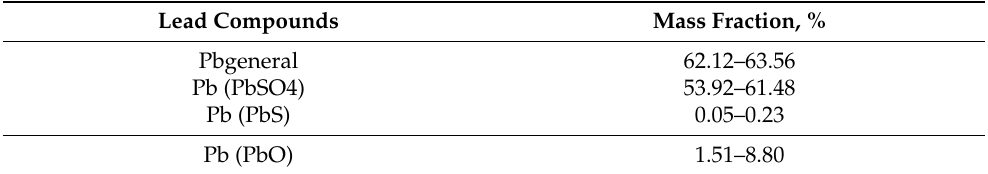
Table 1. Forms of lead in lead sludge.